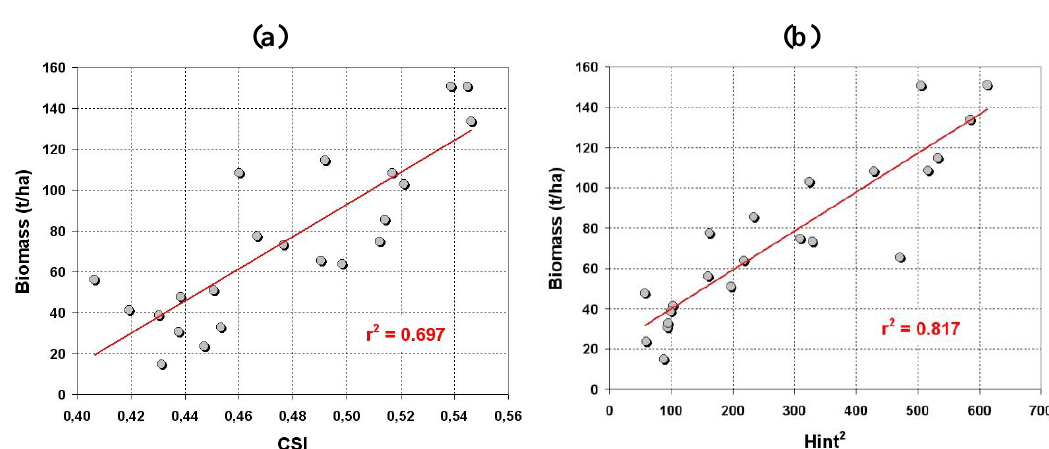
Figure 12. (a) Biomass and CSI; (b) Biomass and Hint 2 .